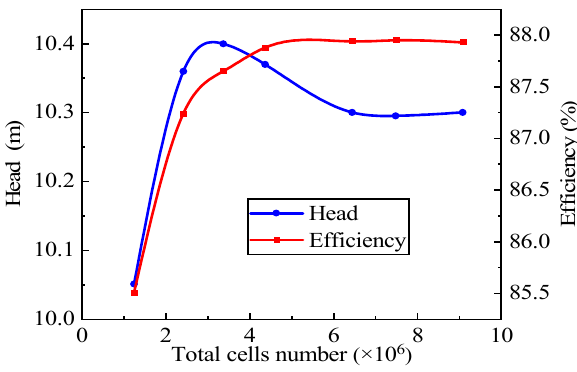
Figure 3. Verification of cells independence.